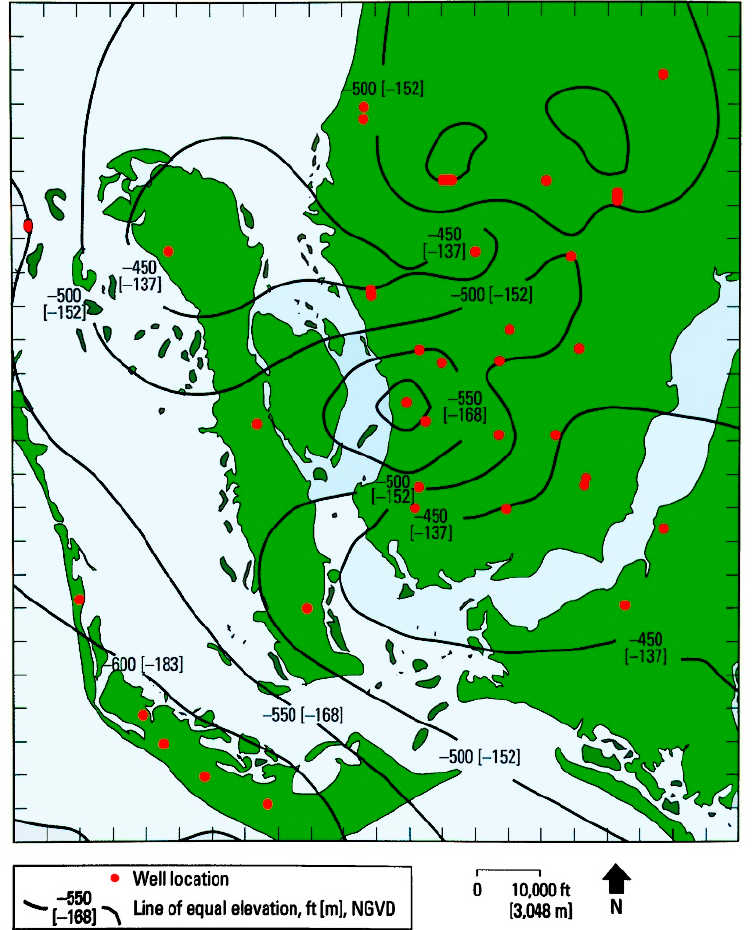
Figure 6. Depth to the top of the Lower Hawthorn Aquifer (from [12,21]).